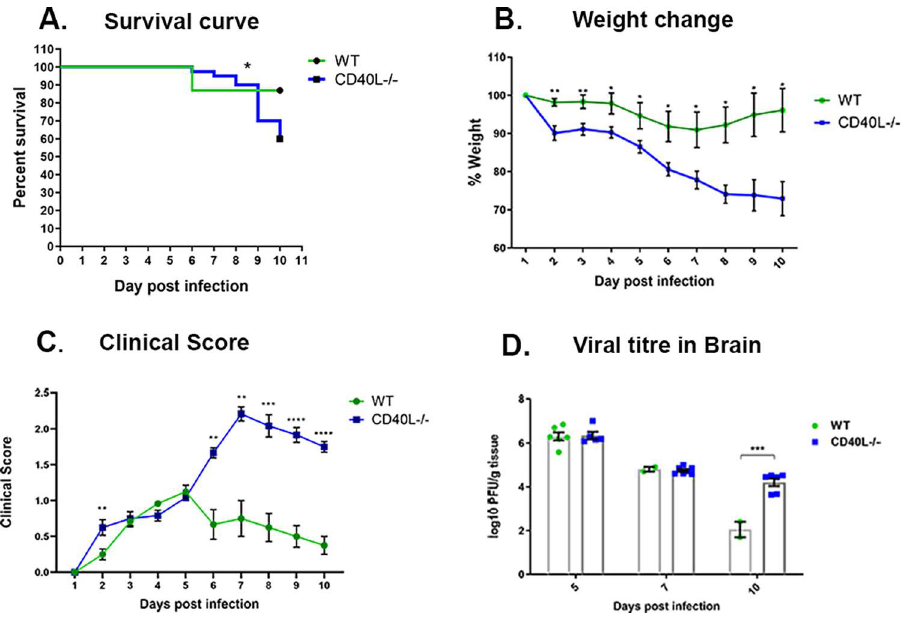
Fig 2. CD40L deficiency makes mice more susceptible to RSA59 infection. WT (N = 17) and CD40L -/- mice (N = 21) were infected with RSA59 (25000 PFUs) and monitored daily for (A) survival, (B) weight change, (C) development of the clinical disease, and (D) viral titers in brains. Clinical scores were assigned by a relative scale of 0–4 as described in Materials and Methods. Results were expressed as mean ± SEM. � Asterisk represents statistical significance calculated using unpaired Student’s t-test, p < 0.05 was considered as significant. Statistical significance for the survival curve was determined by Log-rank (Mantel-Cox) test. � p < 0.05, �� p < 0.01, ��� p < 0.001, ���� p < 0.0001.